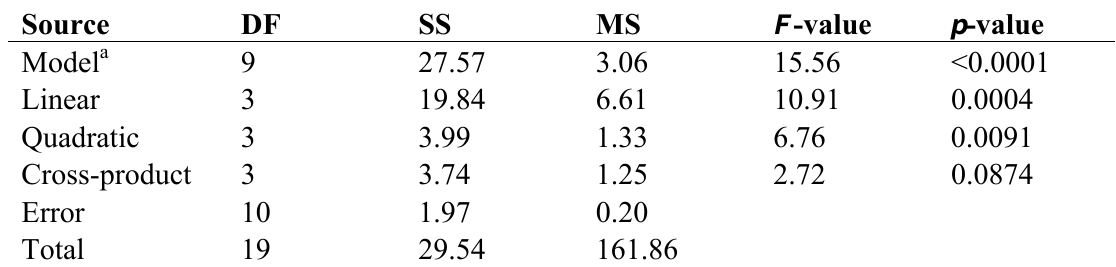
Table 3. Variance analysis of the second-order regression model on polyphenol